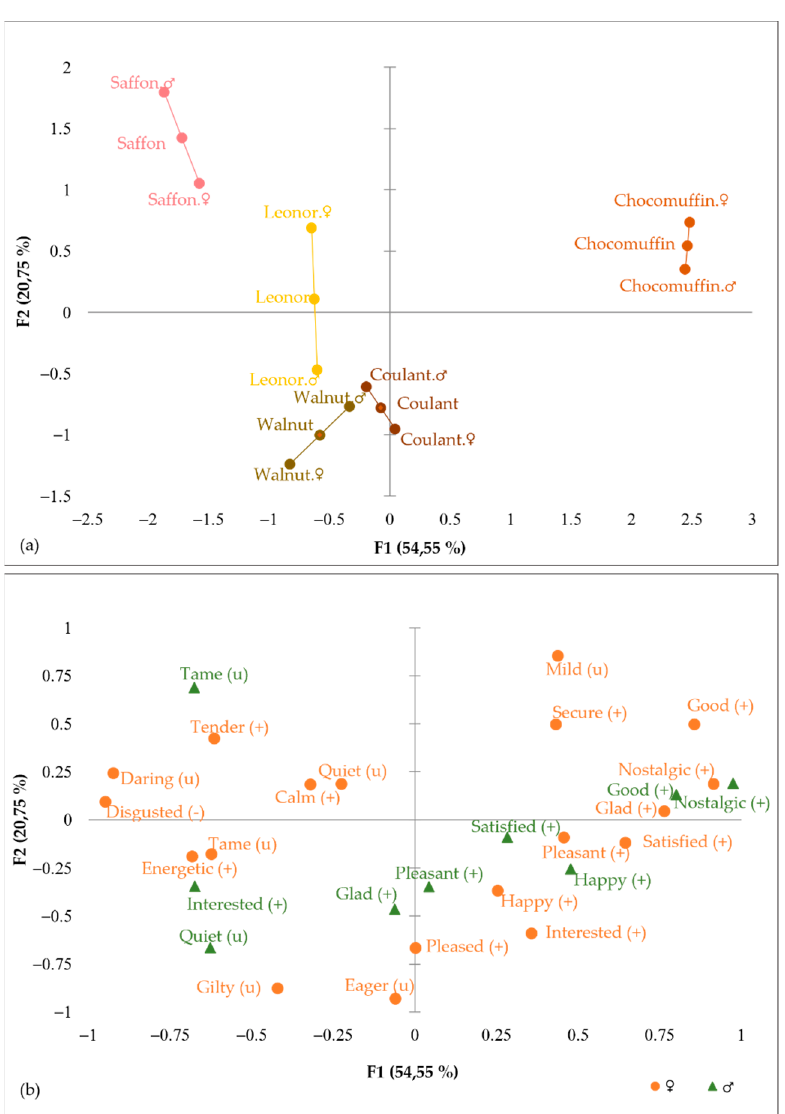
Figure 10. MFA on CATA emotions by gender: ( a ) cakes representation; ( b ) emotion terms of CATA EsSense Profile ® .